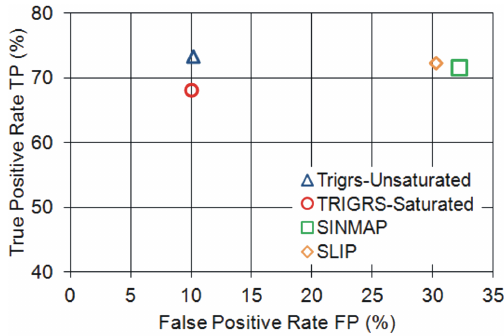
Figure 15. True positive rate (TP) and false positive rate (FP) ob- tained with the TRIGRS-unsaturated, TRIGRS-saturated, SINMAP and SLIP models for the study area considering a geological unit mapping and mean values of soil input